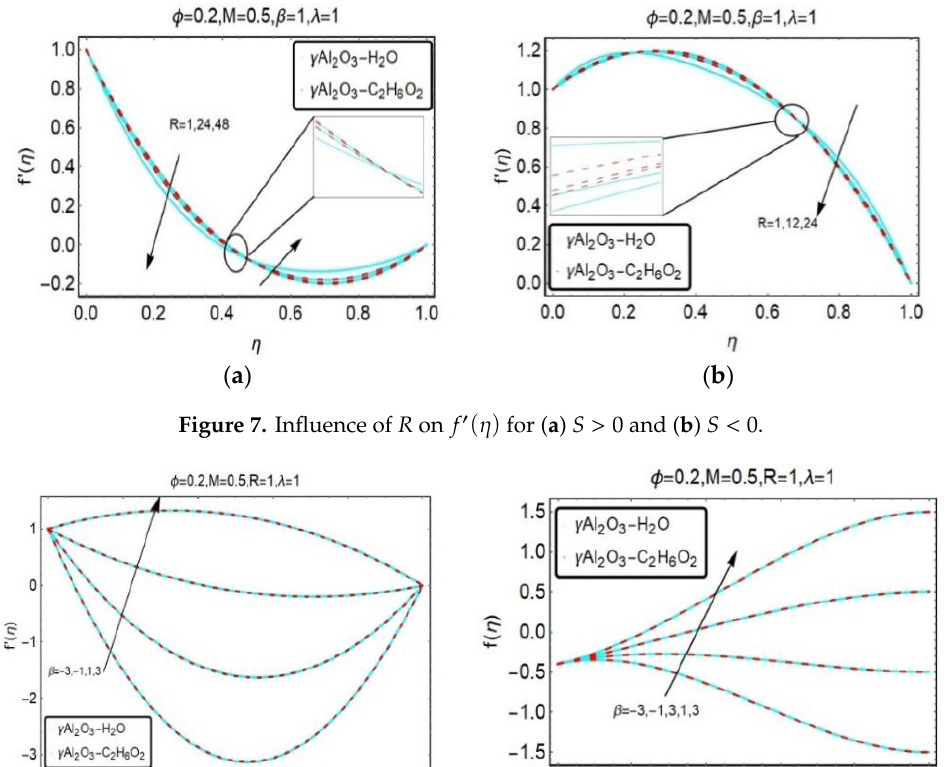
Figure 9. Influence of 𝑀 2 on 𝑓′(𝜂) for ( a ) 𝑆 > 0 and ( b ) 𝑆 < 0 .